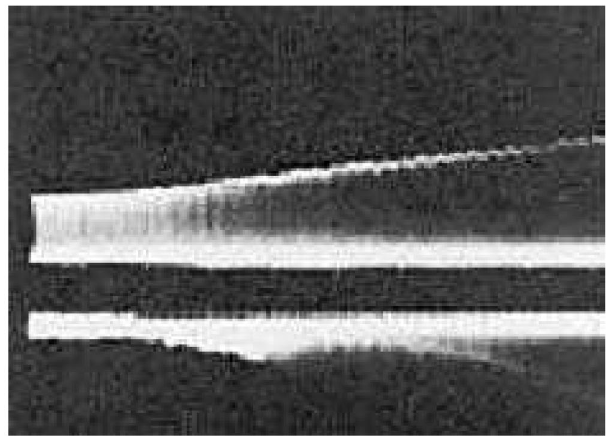
FIG. 3. Observation of coherent vertical instability at the BNL AGS in 1967 [20]; shown are the sum and difference signals from a vertical pickup; horizontal axis is time with 10 ms per division; the graph shows a 2 mm growth in peak-to-peak amplitude, at an intensity of 1 : 15 (cid:1) 10 12 protons.